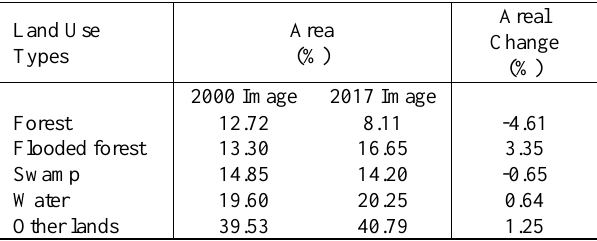
Table 2. The classes used in classification process